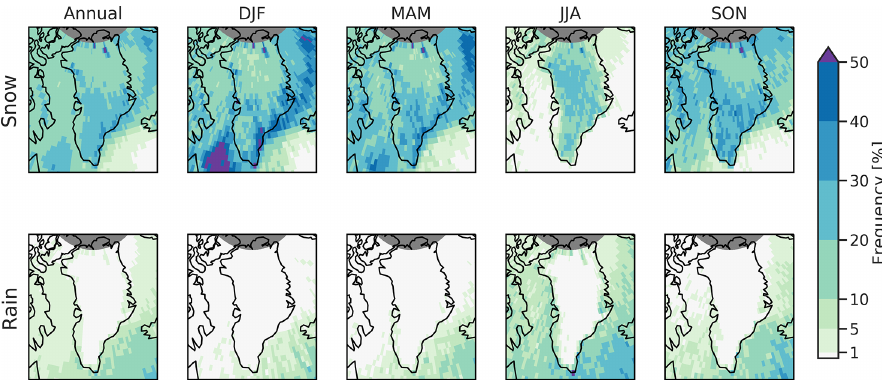
Figure 1. Annual (left) and seasonal (DJF, MAM, JJA, SON, from left to right) mean total snow (light snow + snow, top) and total rain (light rain + rain, bottom) frequency derived from CloudSat cloud-profiling radar (2CPC: 2006–2016).